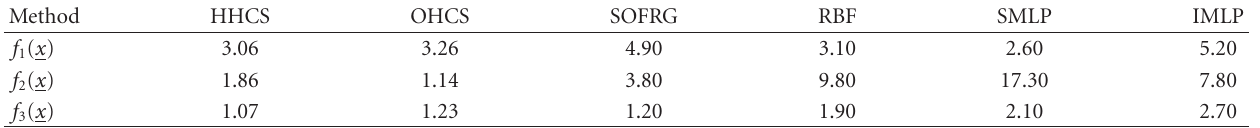
Table 2: Comparison with other neural and neurofuzzy